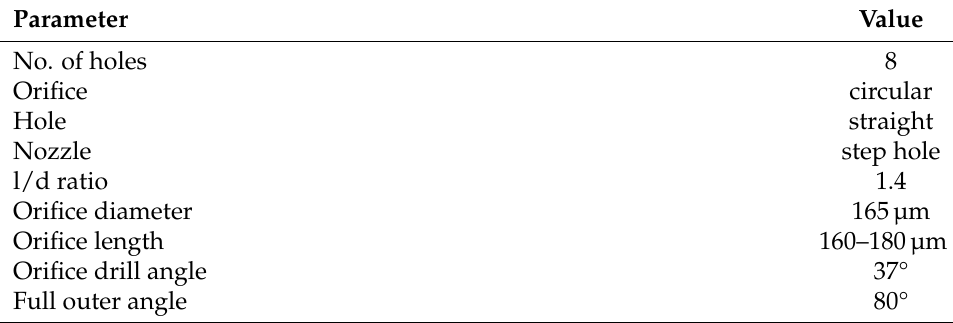
Table 2. Spray G injector characteristics.